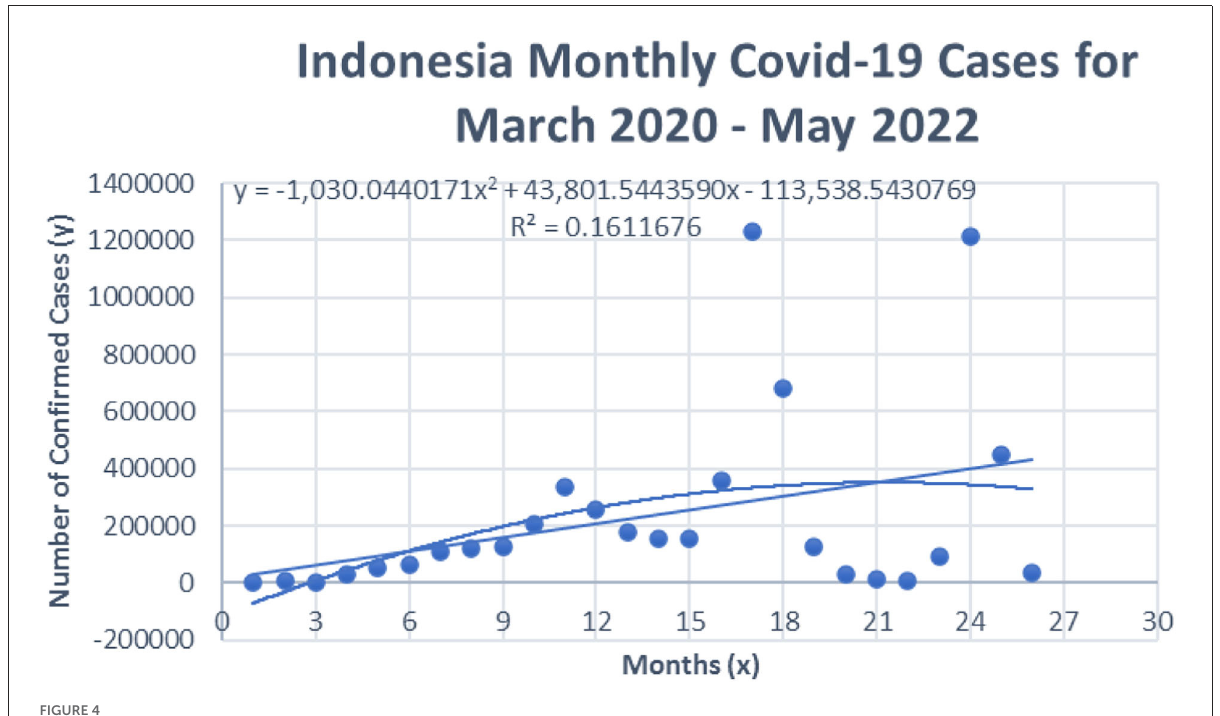
FIGURE4 Nonlinear quadratic trend line for indonesia COVID-19 cases.